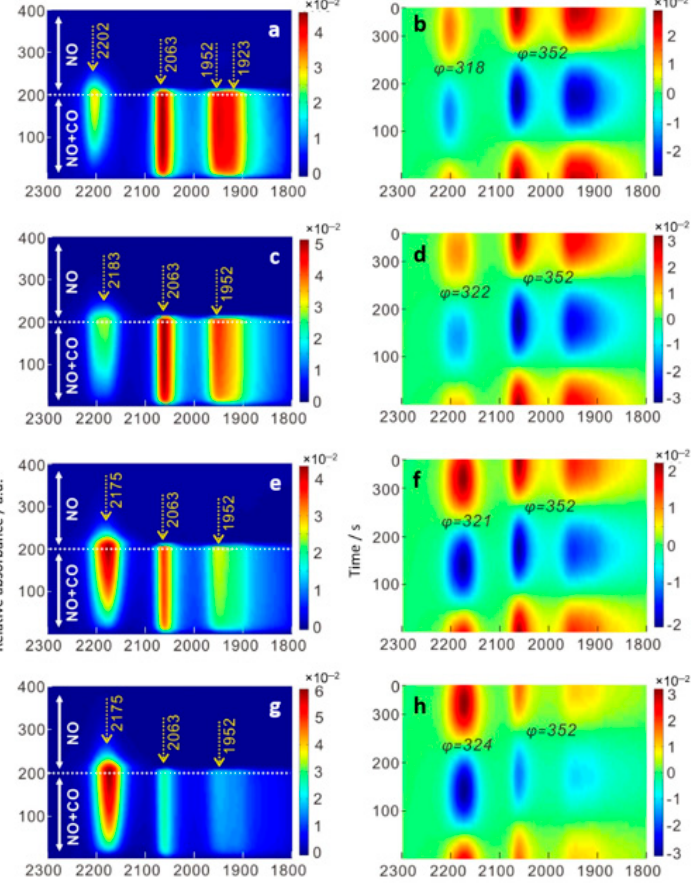
Figure 6. ( a , c , e , g ) Time-domain and ( b , d , f , h ) phase-domain DRIFTS spectra during catalytic reduc- tion of NO with CO on ( a , b ) AuPd/TiO 2 , ( c , d ) AuPd-La(2:1)/TiO 2 , ( e , f ) AuPd-La(1:1)/TiO 2 , and ( g , h ) AuPd-La(1:2)/TiO 2 at 300 °C.